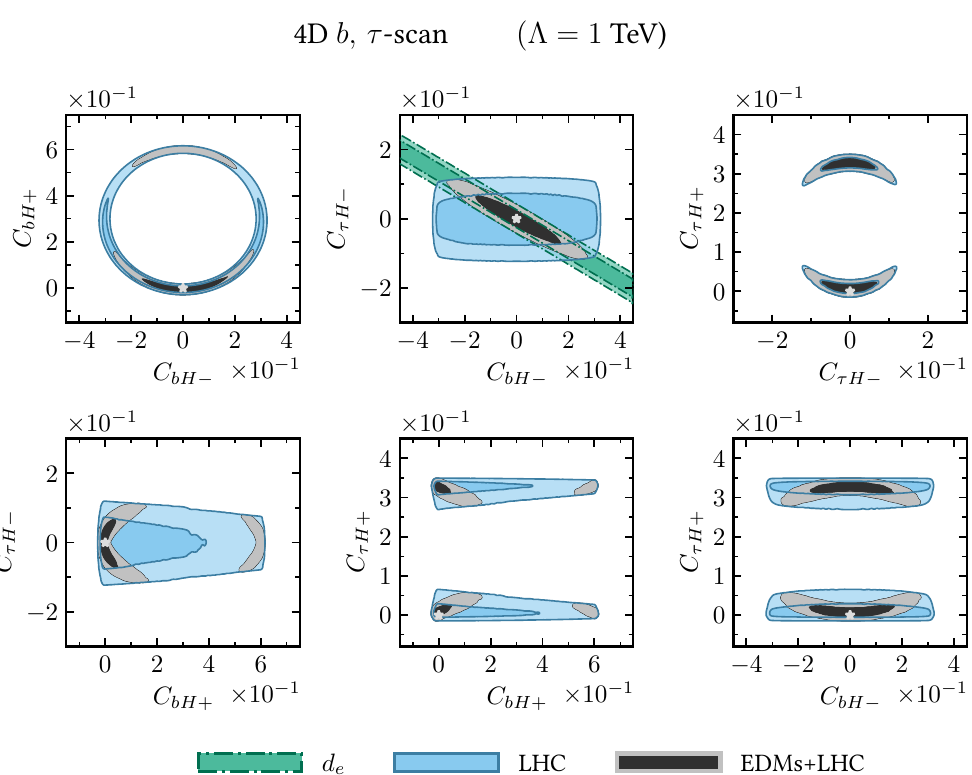
Figure 8 . Constraints resulting from a 4D scan of bottom and τ Wilson coefficients ( C bH ± , C τH ± ) assuming Λ = 1 TeV. In each plot only two parameters are shown, the remaining two are profiled over (see main text). Contours represent the allowed 68% and 95% confidence regions, the colour coding of individual constraints is given in the legend, and grey/black areas correspond to the combined regions. For details see main text and the caption of figure